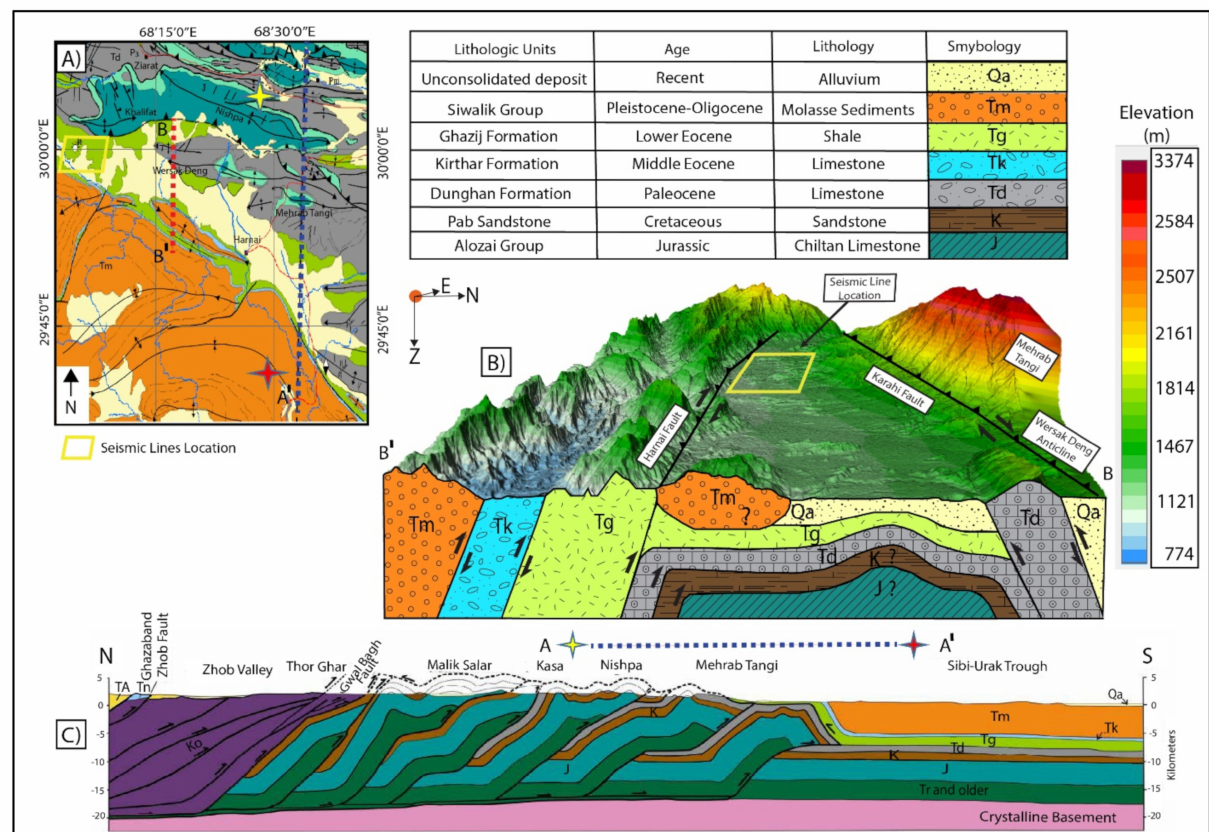
Figure 4. ( A ) The geological map of the western Suleiman Fold Belt showing both structural and stratigraphic elements. Dotted lines A-A’ and B-B’ show the location of the structural cross-section in ( B , C ). ( B ) Surface topography and structural cross-section across the Harnai and Karahi faults. The yellow rectangle shows the seismic location and coverage. ( C ) Structural cross-section in the eastern part of the study area showing the fault-related folds in the form of duplexes. ( B , C ) are modified after Maldonado et al. [26] and Jadoon et al.